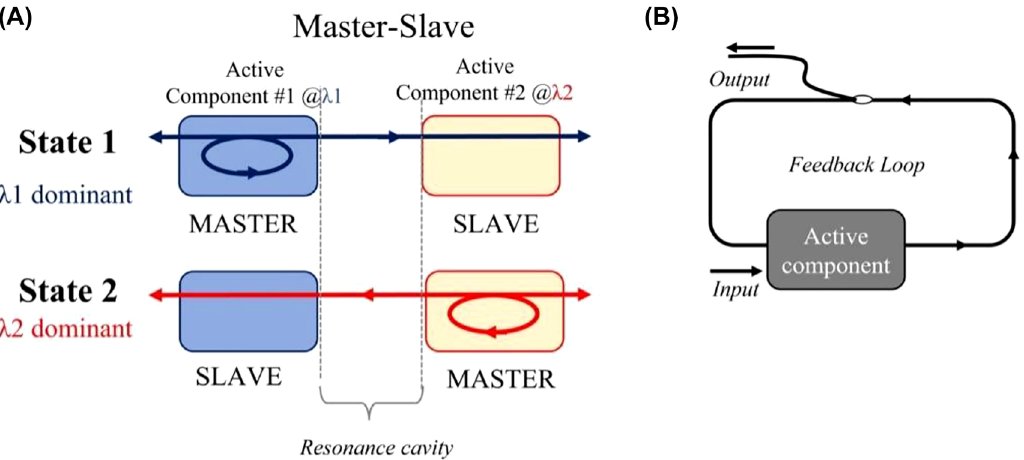
Figure 7: Optical memory with SOA-based bistability based on: (A) master-slave configuration, (B) feedback loop